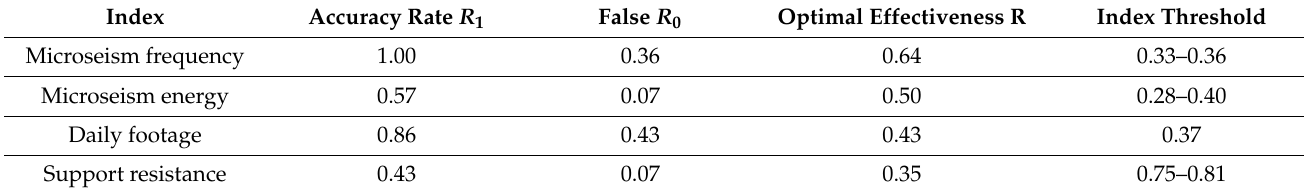
Table 5. Early warning effectiveness and weight analysis of each index.